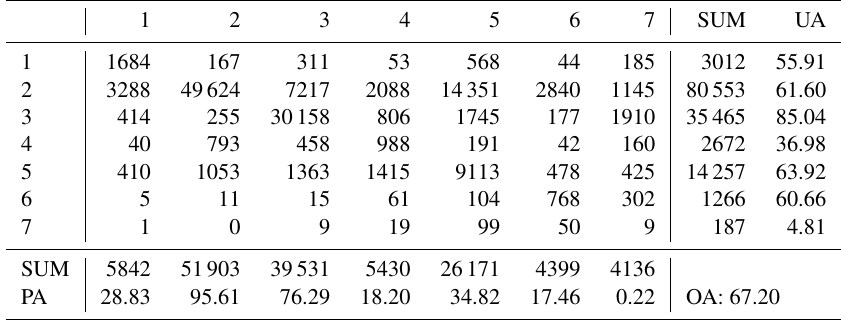
Table B7. Confusion matrix for LANDMATE PFT group 0.7 – the dominant LULC type occupies a minimum of 70% of a LANDMATE PFT grid cell.